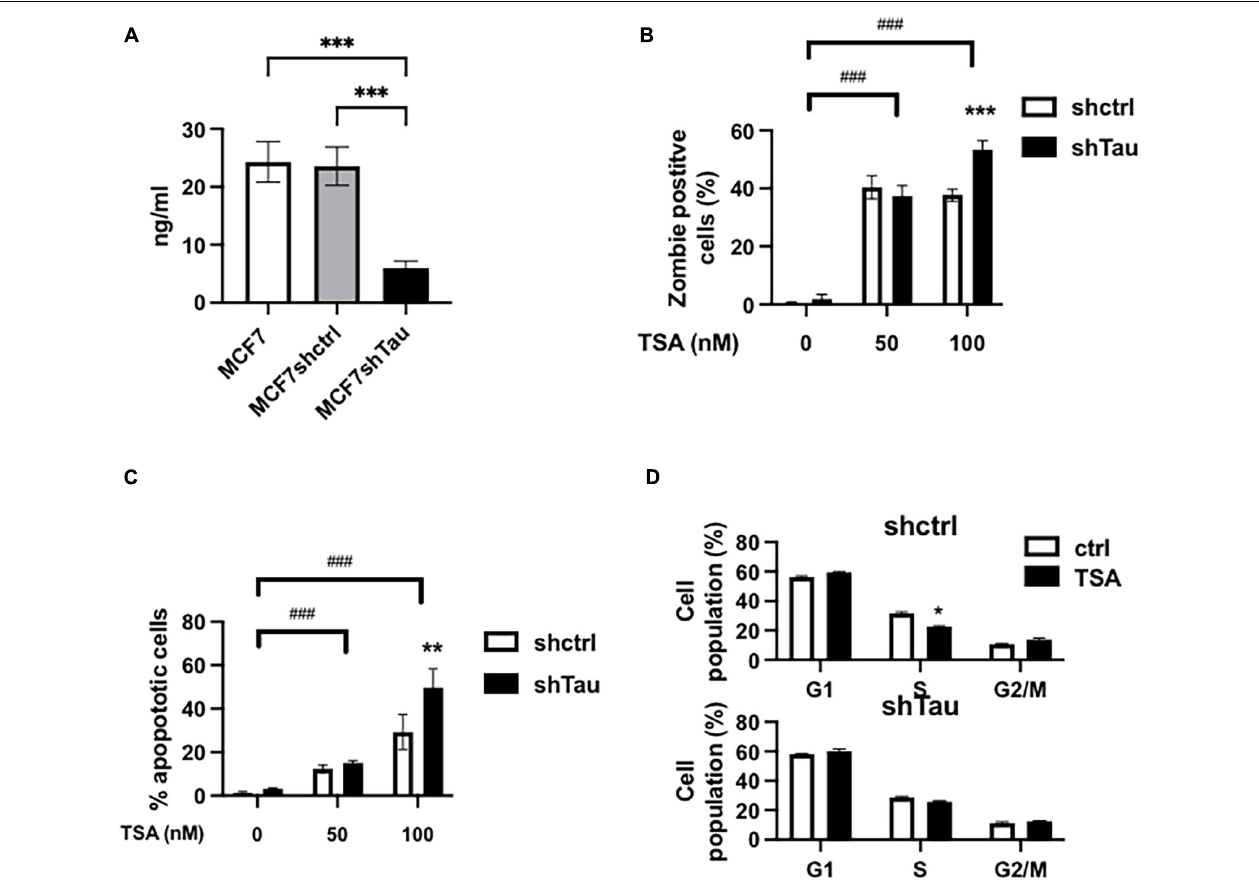
FIGURE 1 | Tau inhibition increases MCF7 breast cancer cell line sensitivity to TSA. (A) Tau protein expression in MCF7, MCF7shctrl, and shTau were quantify by ELISA. (B) Effect of 50 and 100 nM TSA (48 h) on cell death in the MCF7shctrl and MCF7shTau subclones. Cell death was determined by staining and flow cytometric analysis as described in section “Materials and Methods.” (C) Effect of 50 and 100 nM TSA (48 h) on apoptosis in the MCF7shctrl and MCF7shTau subclones. Apoptosis was determined by flow cytometric analysis of the PI-positive and Annexin-V-positive cells as described in section “Materials and Methods.” (D) Cell cycle distribution was determined by FACS analysis of combined propidium iodide and EdU staining in MCF7shctrl and MCF7shTau in the absence or presence of 100 nM TSA, 48 h. Data are mean ± SD, * P < 0.05, ** P < 0.01, *** P < 0.001, ### P < 0.001. All results are representative of three independent